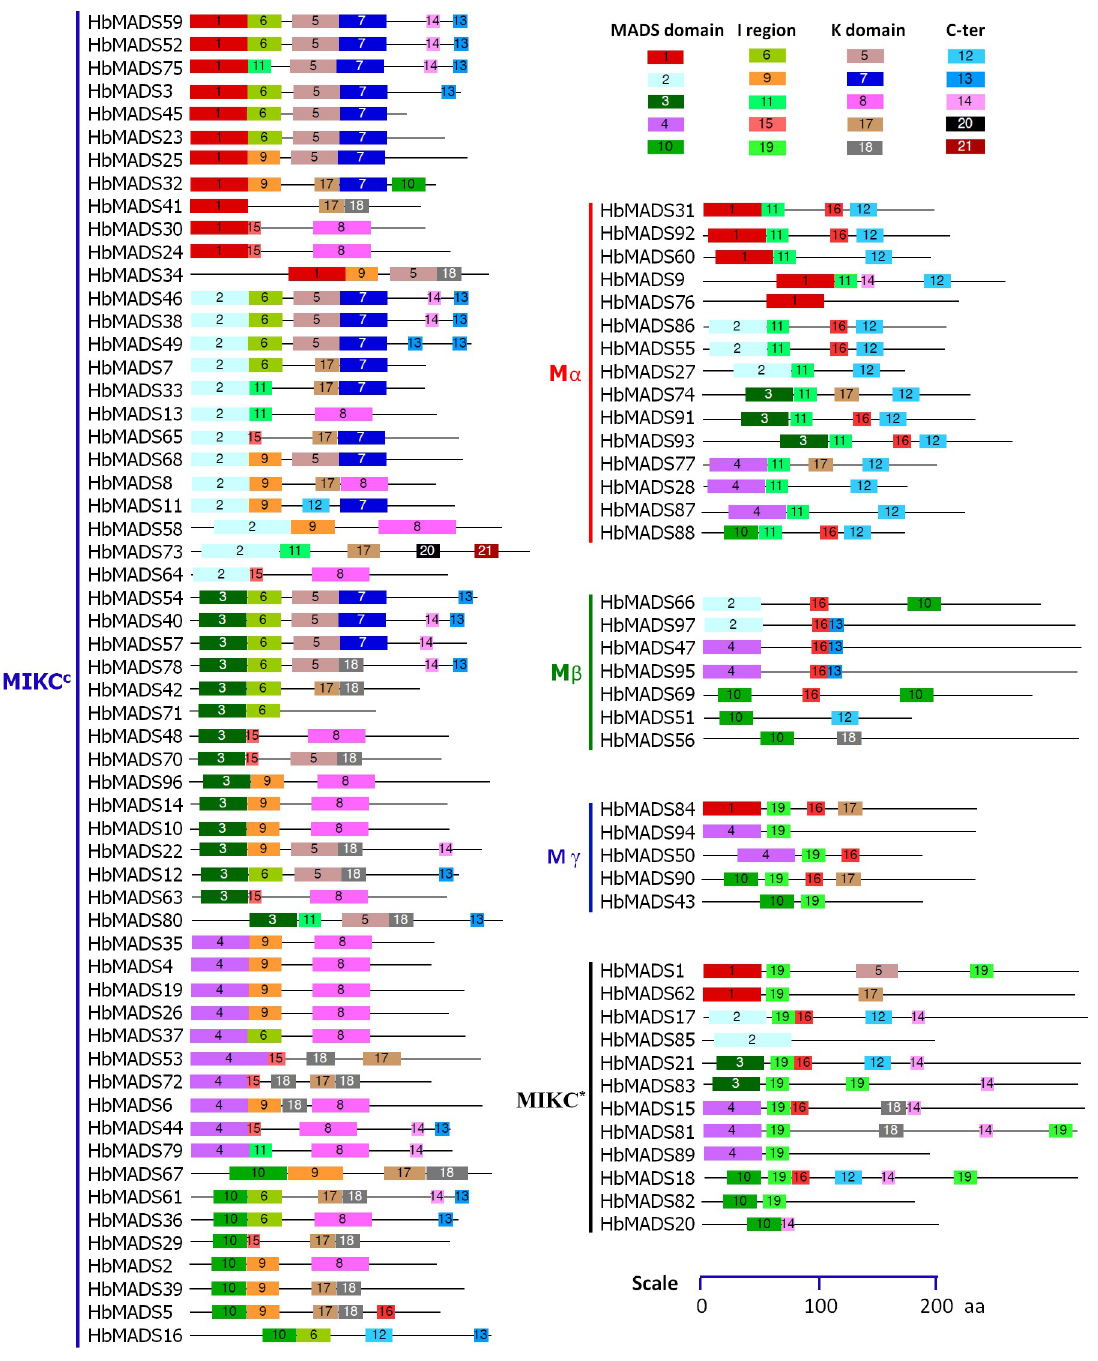
Fig 3. Conserved motifs of MADS-box factors in the rubber tree. The motifs were identified with MEME Suite 5.03 [42] and confirmed in InterPro database (http://www.ebi.ac.uk/interpro/). Motifs are shown by different color boxes, while non-conserved sequences are shown in grey line. Length of motifs is present in